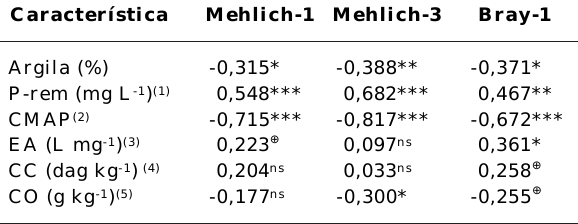
(1) P-rem - Fósforo remanescente. (2) CMAP - Capacidade máxi- ma de adsorção de fósforo. (3) EA – “Energia de adsorção”. (4)